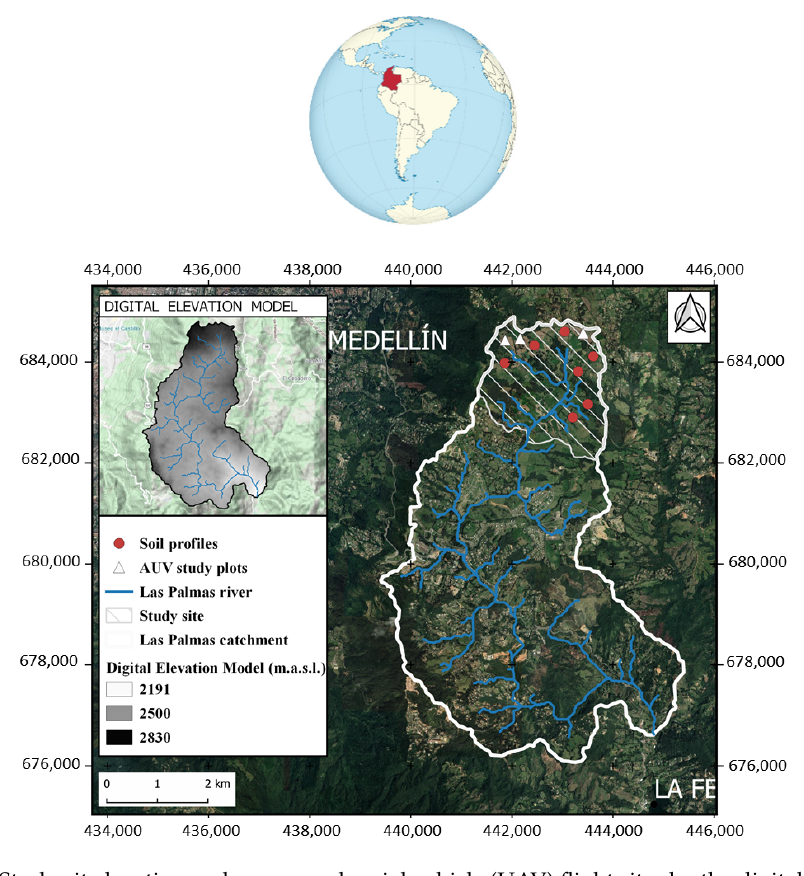
Figure 1. Study site location and unmanned aerial vehicle (UAV) flight sites by the digital elevation model (DEM 12.5 m) of the Las Palmas catchment area, Antioquia, Colombia, South America. Source: Current research